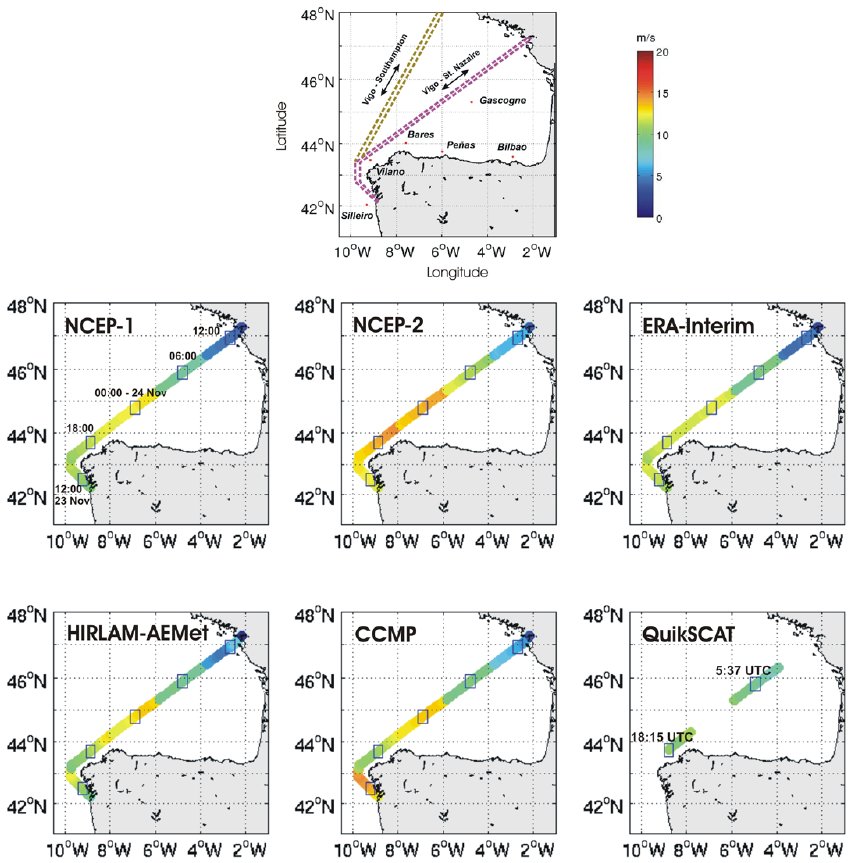
Fig. 1. Map of the Bay of Biscay showing ECO routes with 1p CO 2 measures from September 2002 to September 2003 (top and left panel). These routes departed from the port of Vigo (Spain), usually to Saint Nazaire (France) and rarely to Southampton (UK). The ocean buoys used in the study (Silleiro, Vilano, Bares, Pe˜nas, Bilbao and Gascogne) are also shown. The rest of the panels show the wind field interpolated in space (cubically in the case of models and collocated in satellite-derived winds) and time ( < 3h) to the first available route on 23 and 24 November 2002 as taken from different products (NCEP-1, NCEP-2, HIRLAM-AEMet, ERA-Interim, CCMP and QuikSCAT). The reference times of the wind products are marked over the route (blue